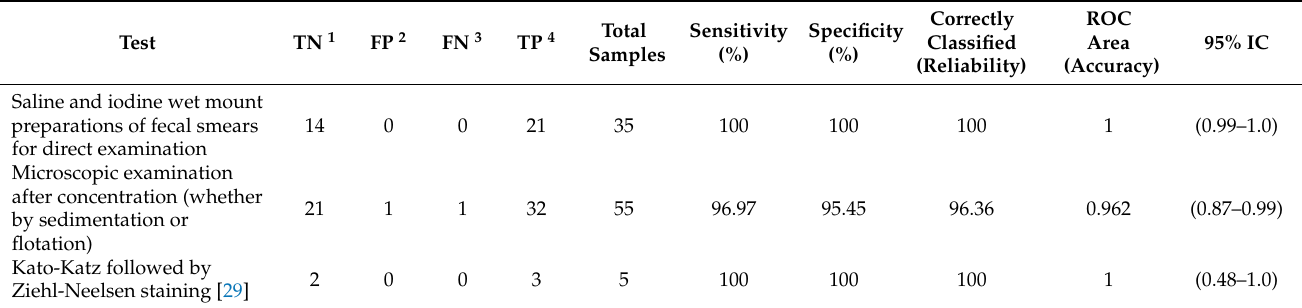
Table 11. Diagnostic accuracy by test of the microscopic copro-Ring Trial.